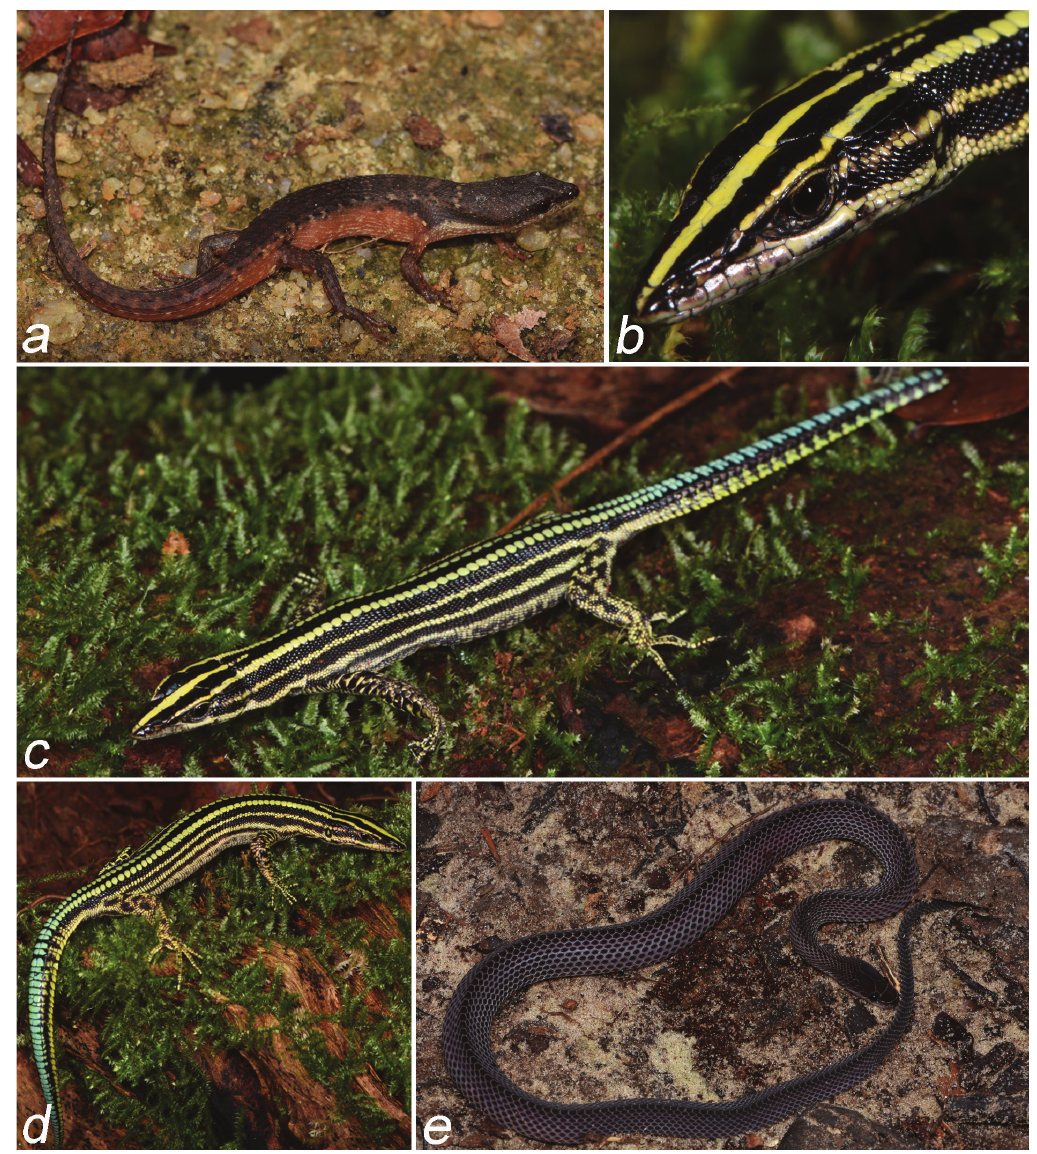
Figure 6. a Cophoscincopus simulans male (ZMB 88507) from FPPA b , c Holaspis guentheri male (ZMB 88471) d Holaspis guen- theri female (ZMB 88472) from KBPPA e Juvenile Goniontophis klingi (ZMB 88467) from